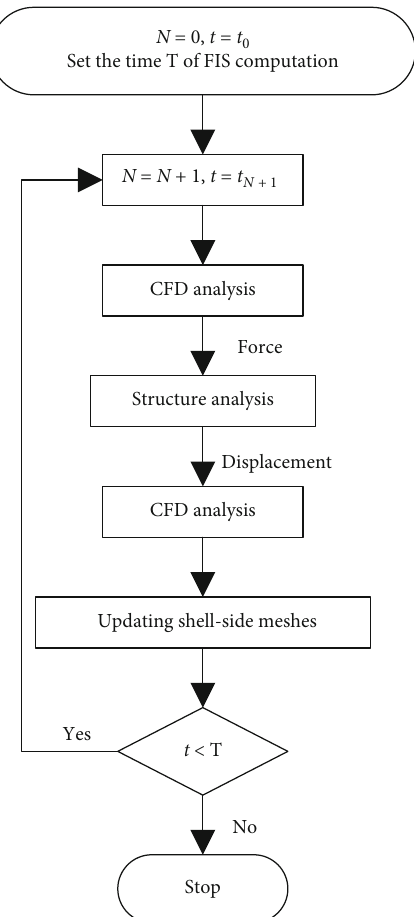
Figure 4: The schematic diagram of the fl uid-structure calculation